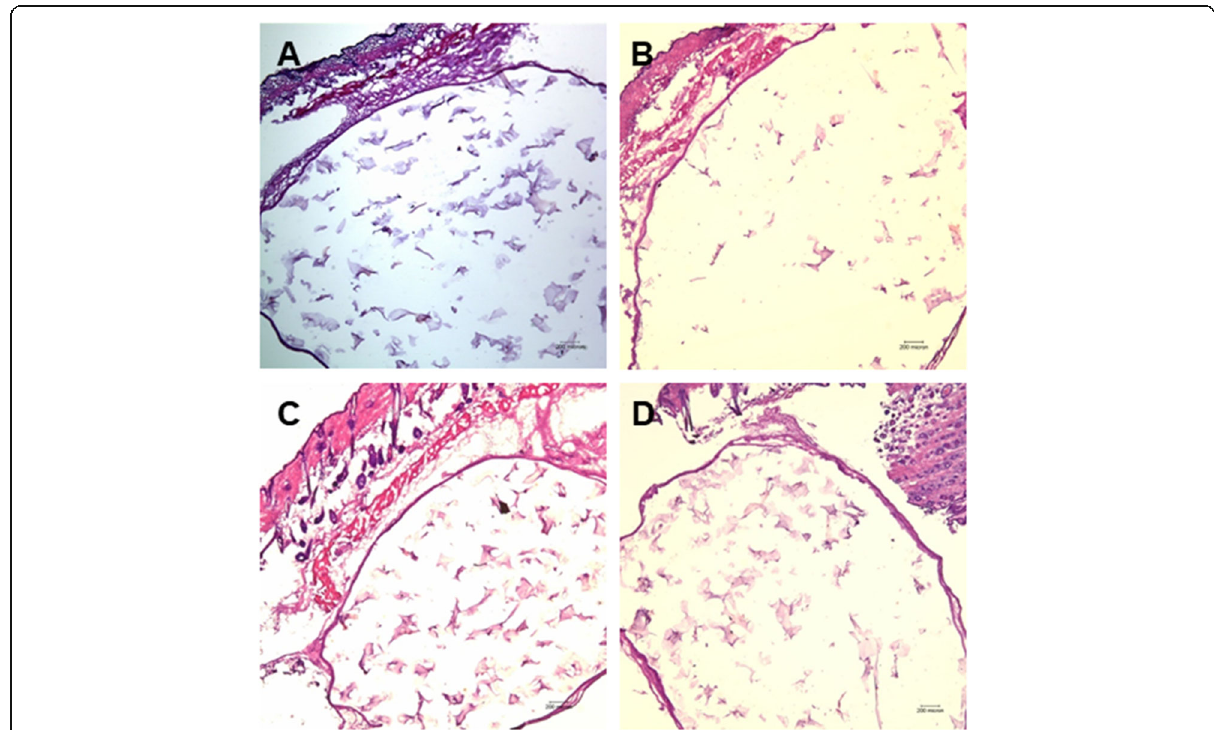
Fig. 4 Microscopic view of the hyaluronan gel filler (HGF) groups stained with HE. All groups showed no soft tissue regeneration. HGF remained surrounded by a thin fibrous capsule (HE; original magnification, × 40). a Hyaluronan gel filler alone, b hyaluronan gel filler combined with bFGF, c hyaluronan gel filler combined with fibroblasts, and d hyaluronan gel filler mixed with bFGF and